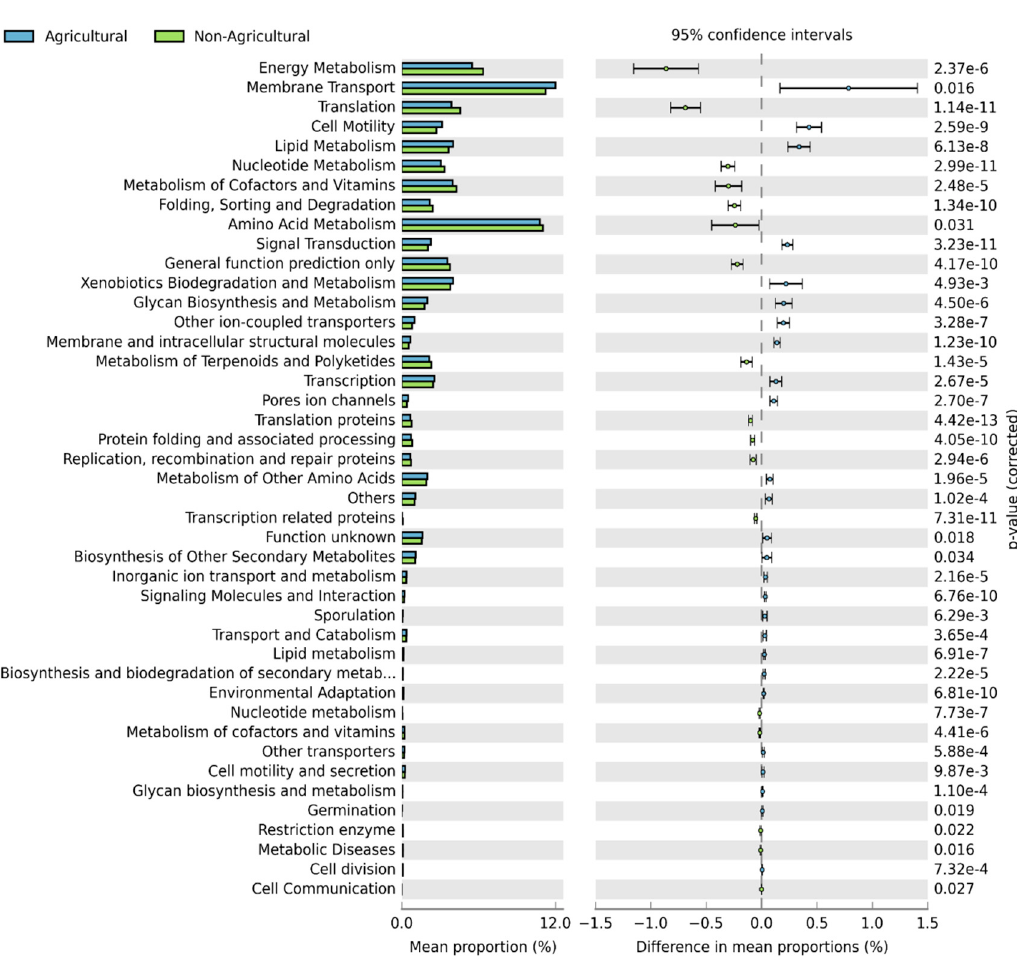
Figure 6. Extended error bar plot showing the mean proportion (%) of significantly different predicted functional categories at level 3 found in soil bacterial communities. Points indicate the differences between agricultural and non-agricultural soil (blue and green bars, respectively), and the values on the right show the p -values that were derived from a White’s non-parametric t-test [36].